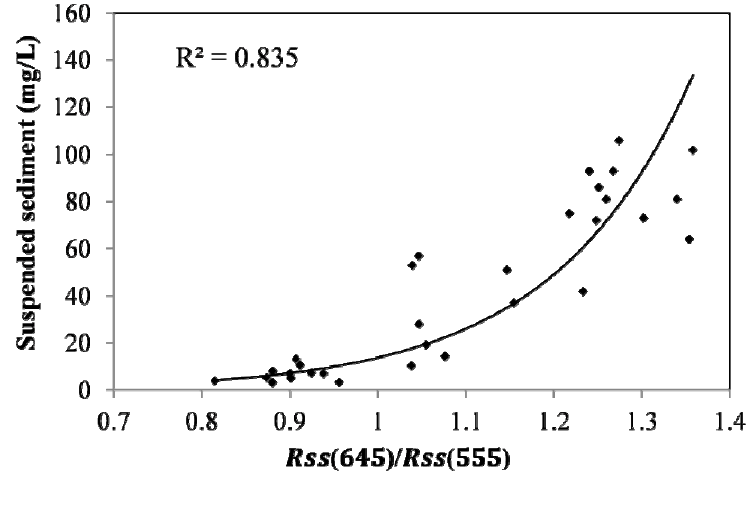
Figure 2. Matched in situ suspended sediment and remote sensing reflectance retrieved from Moderate Resolution Imaging Spectra-radiometer (MODIS)